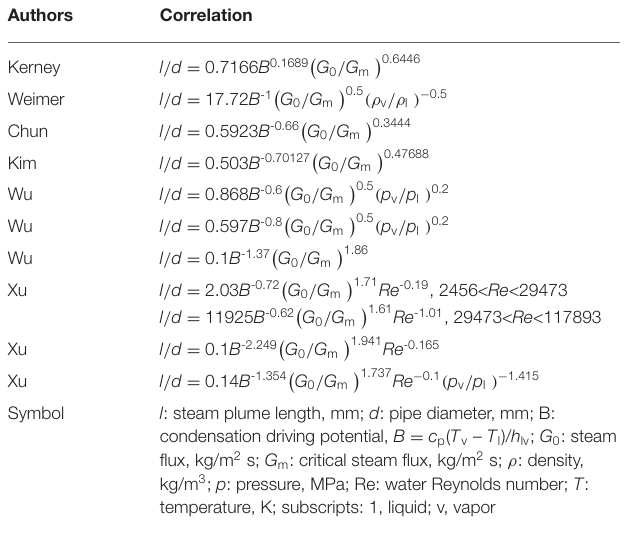
TABLE 1 | Summary sheet of correlations for dimensionless length of steam